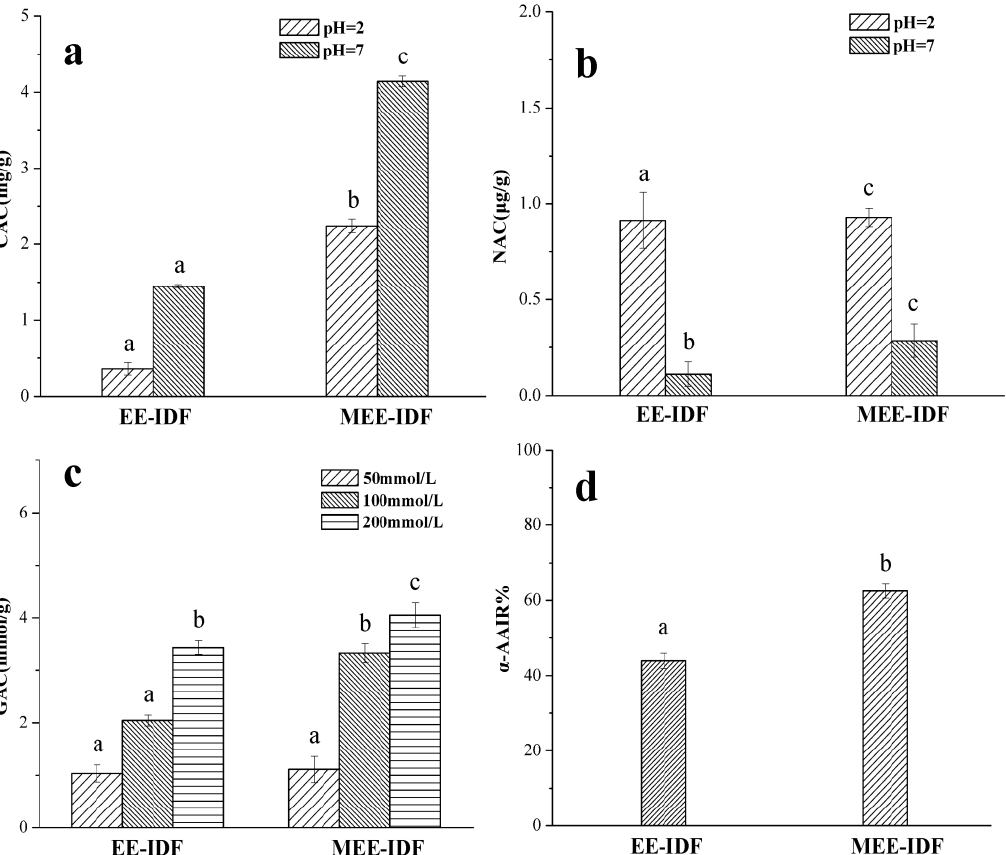
Figure 6. Hypoglycemic activity of IDFs obtained with different extraction methods. CAC ( a ), NAC ( b ), GAC ( c ), and α -AAIR ( d ). Different letters are statistically different ( p < 0.05).